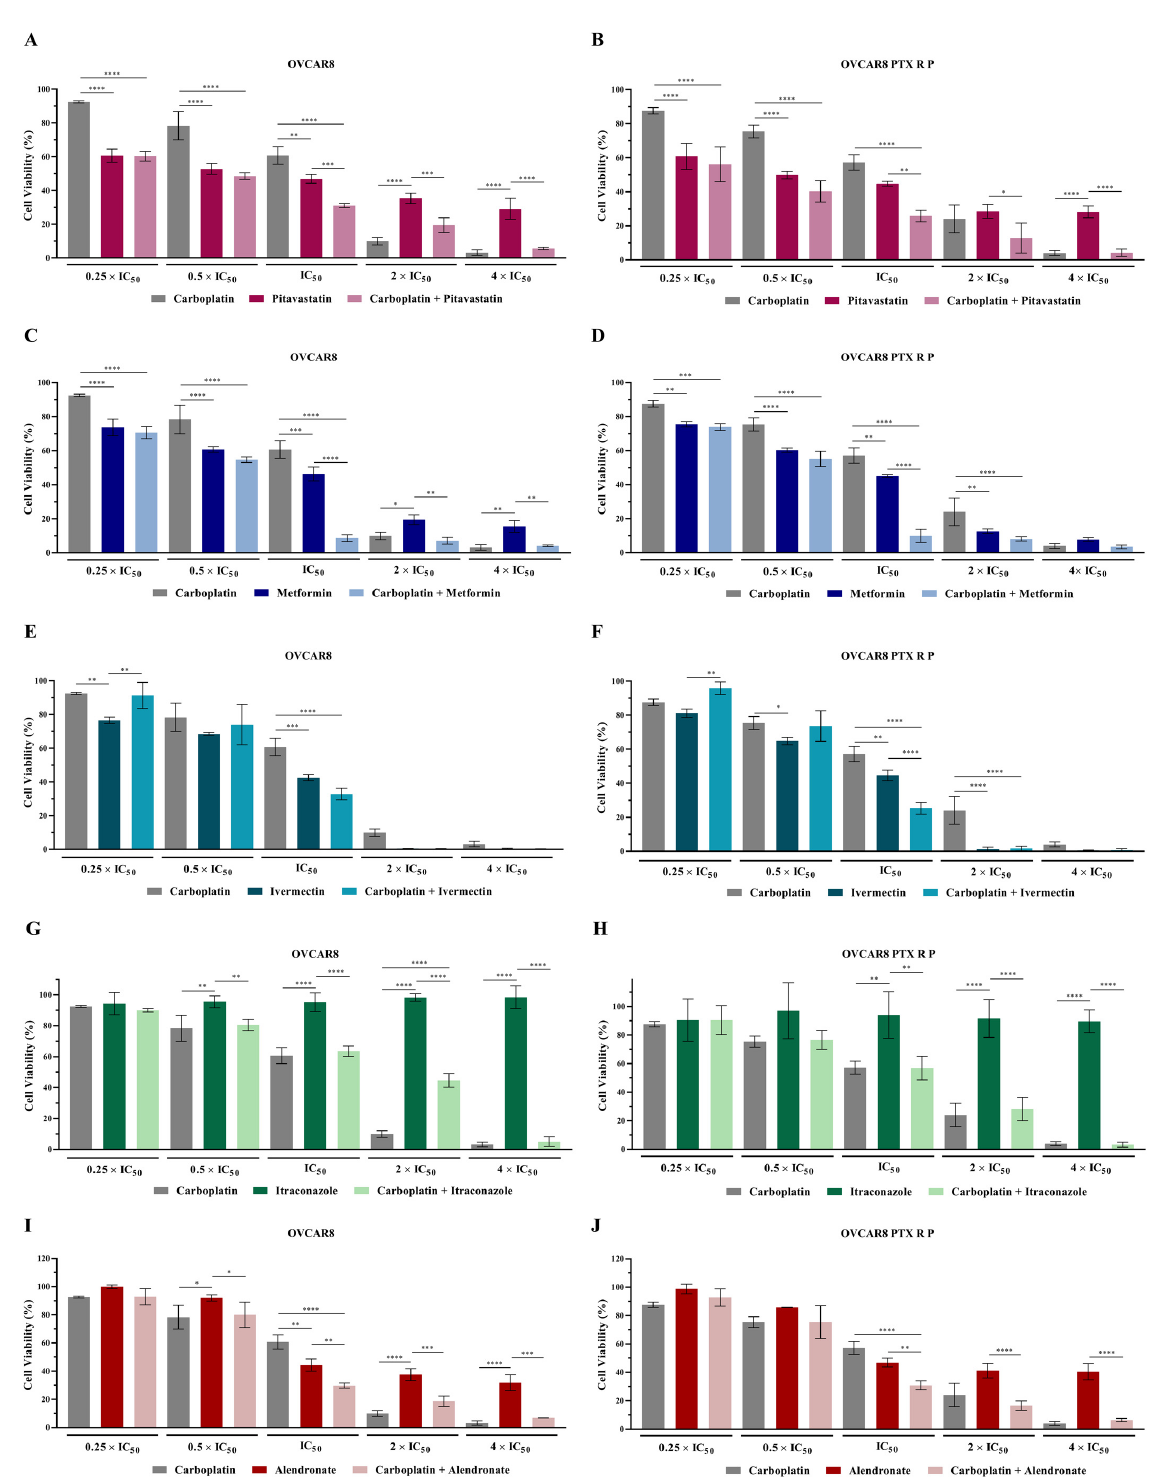
Figure 1. Repurposed drugs increase the efficacy of Carboplatin in reducing cellular viability of chemoresistant high-grade serous carcinoma cells. ( A – J ) Bar charts showing cell viability